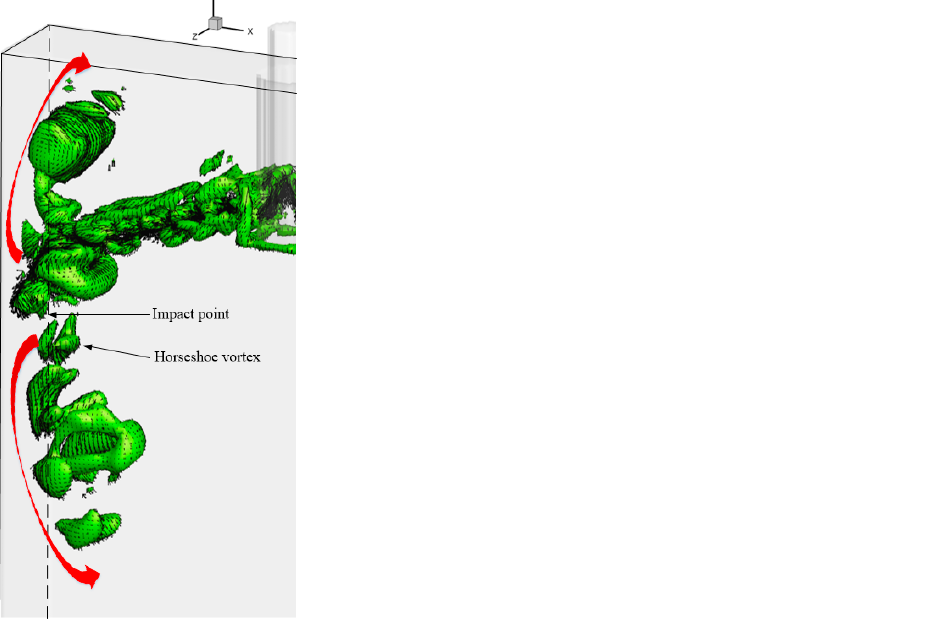
Figure 8. Distribution of coherent structures at impact point along the narrow wall of the mold.